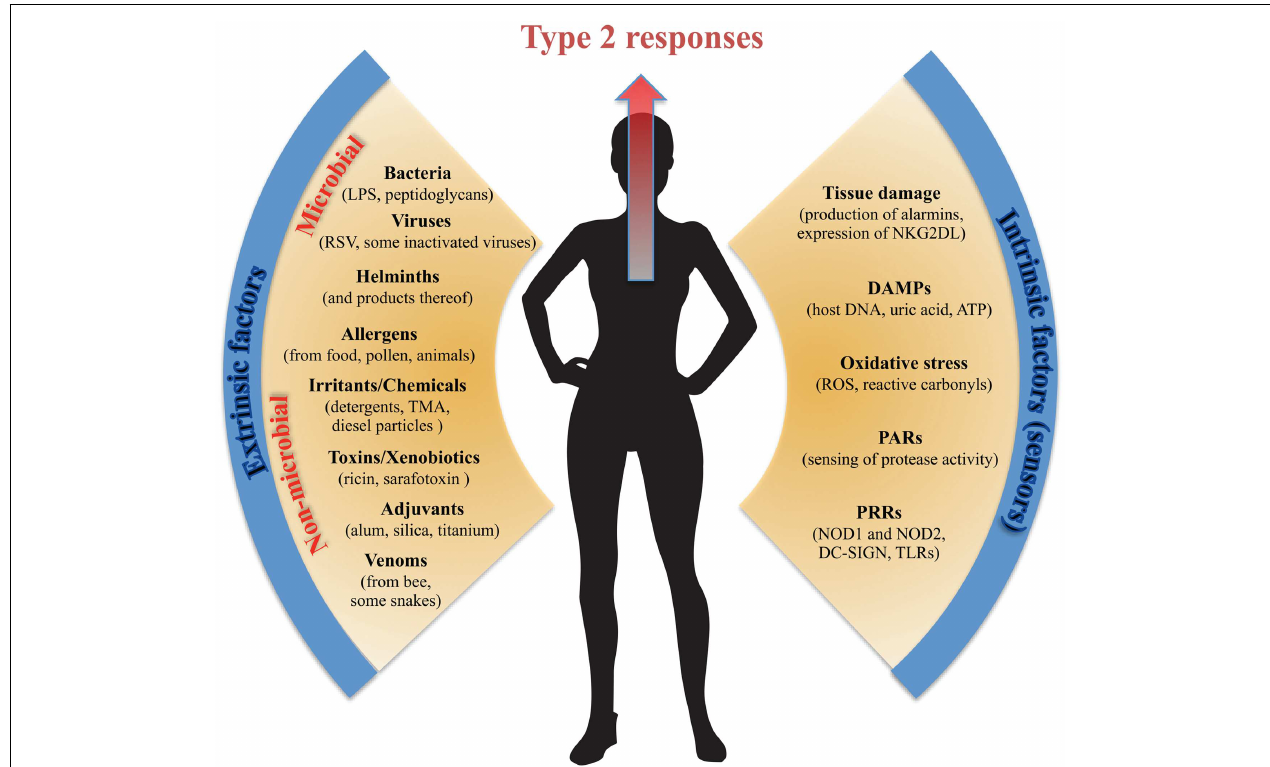
and/or sensing type 2-triggering extrinsic stimuli are many and diverse. In common, most of the extrinsic factors promoting type 2 immunity, as well as the intrinsic factors sensing them, are founded on a breach of the protective barrier of the body and thus on tissue and cellular